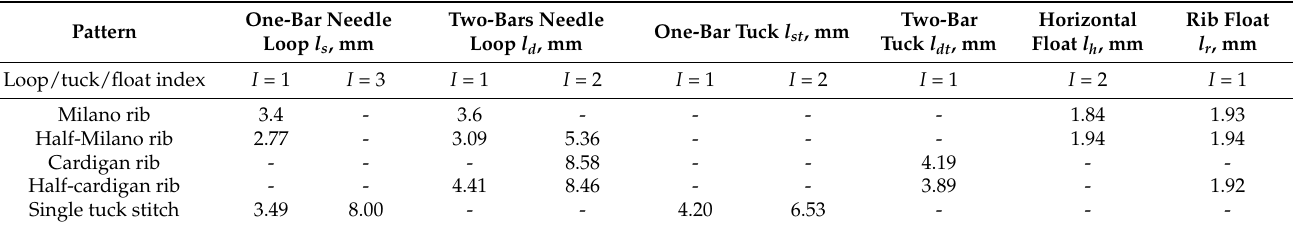
Table 3. Theoretically calculated lengths of structure